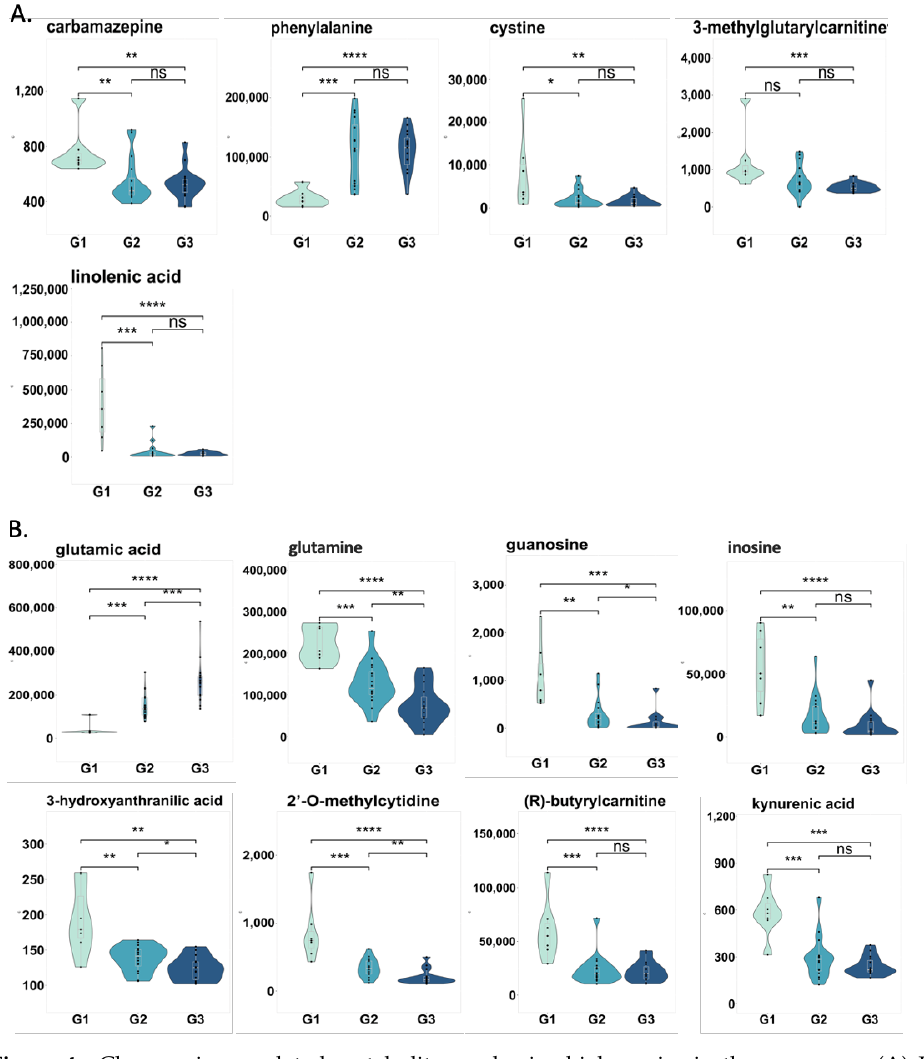
Figure 4. Changes in correlated metabolites and microbial species in three groups. ( A ) Fecal metabolites. ( B ) Serum metabolites. G1: non-alcoholic control subjects; G2: patients with alcohol-associated non-progressive liver disease; G3: patients with alcohol-associated progressive liver disease. ns: p > 0.05; *: p < 0.05; **: p < 0.01; ***: p < 0.001; ****: p < 0.0001.